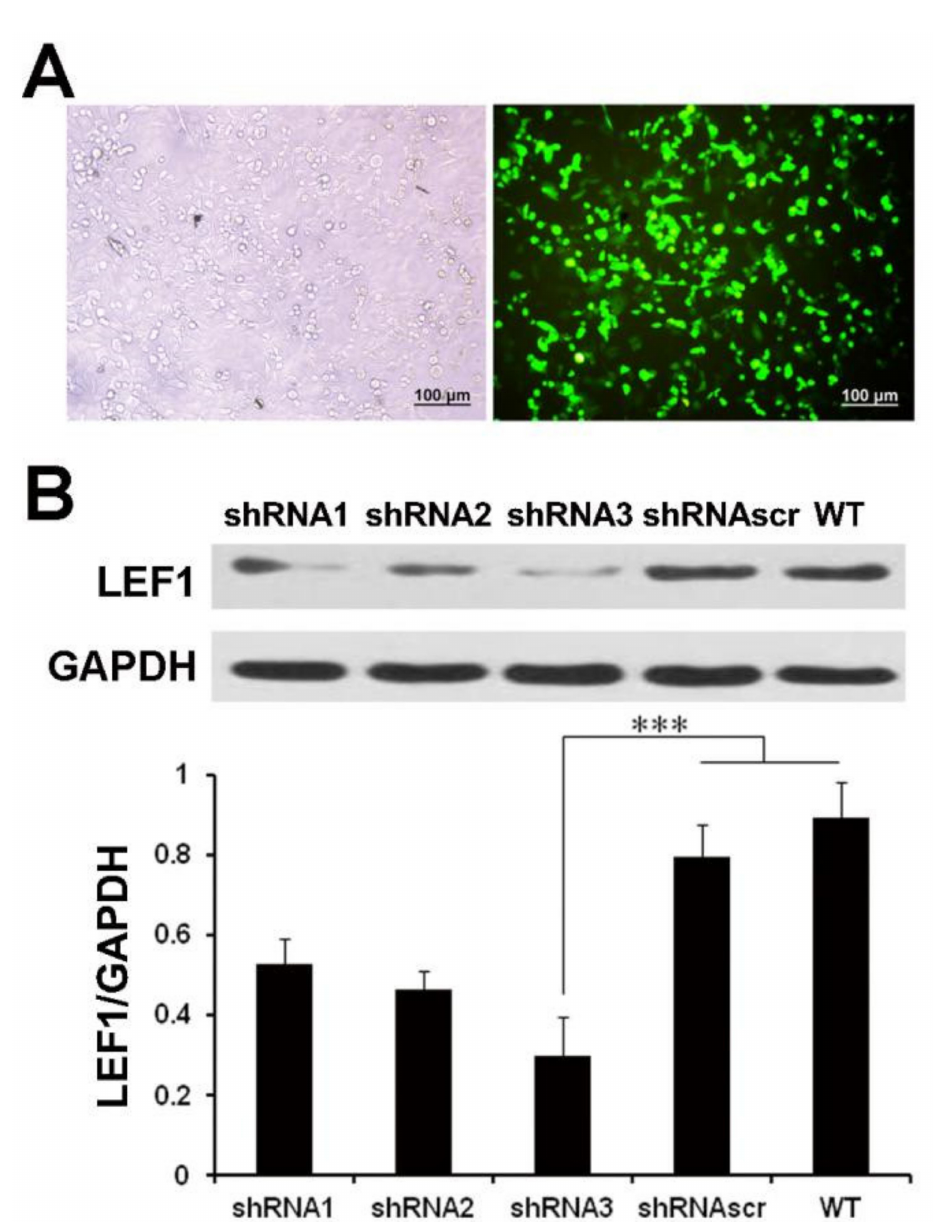
Figure 2. LEF1 expression was efficiently inhibited in caco2 cells. ( A ): The transfection efficiency of shRNAscr detected using an inverted fluorescence microscope at 48 h post-transfection in caco2 cells (scale bar = 100 µ m). ( B ): Western blot analysis revealed that the LEF1 expression levels of the shRNA1, shRNA2 and shRNA3 groups were significantly inhibited compared with the WT and shRNAscr groups. *** p <